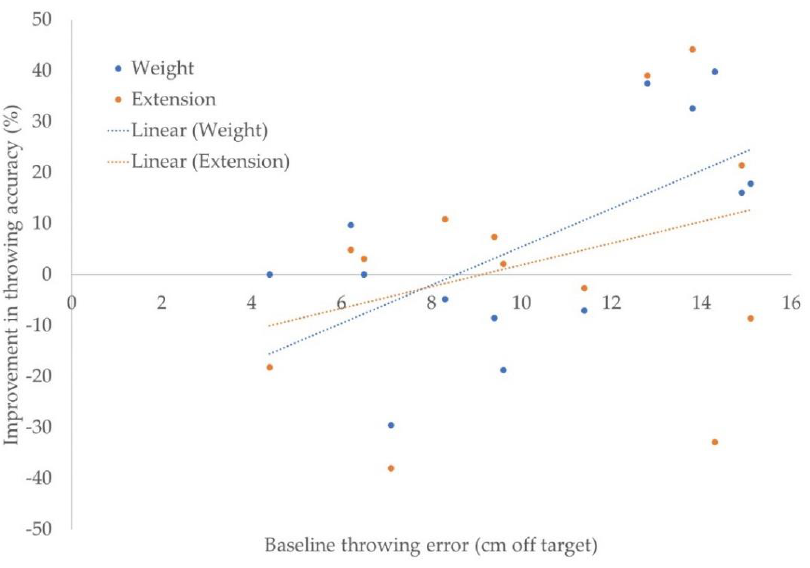
Figure 2. Correlation between skill level and magnitude of benefit from the modifications. R 2 = 0.1 for the leg extension modification and 0.4 for the added weight modification.